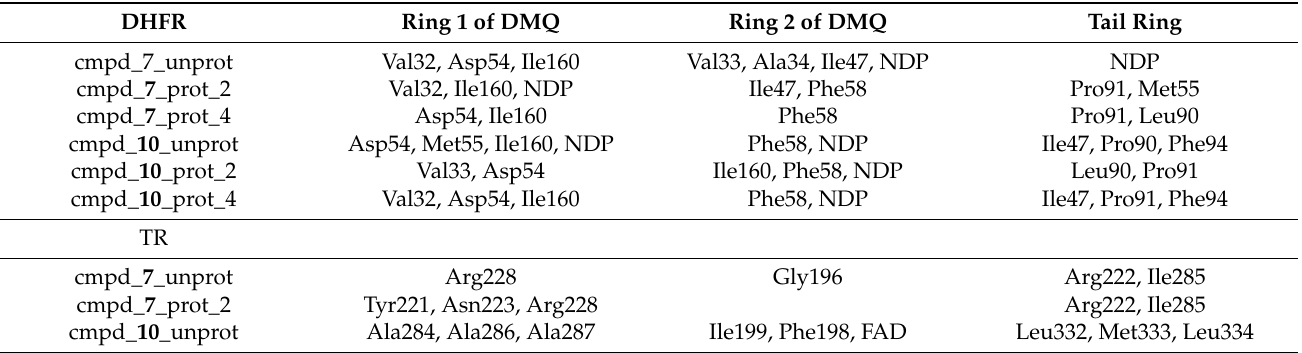
Table 5. Residues interacting with compounds 7 and 10 within the binding sites of DHFR and